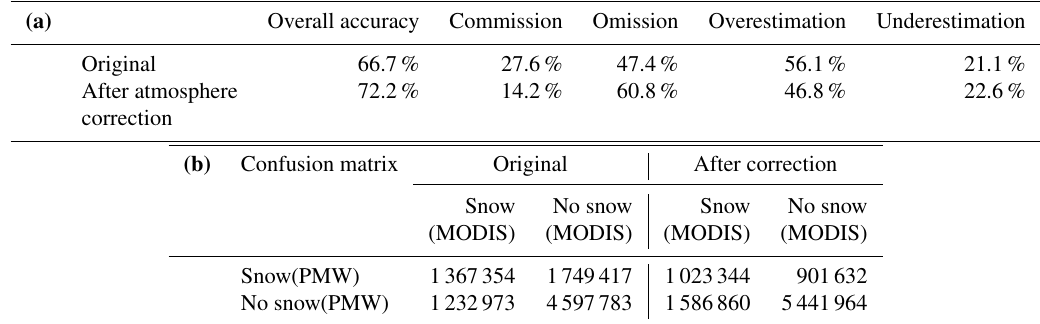
Table 2. Errors in snow cover derived from AMSR-E data and atmosphere-corrected AMSR-E data over the QTP, based on MODIS snow cover fraction (a) , and corresponding confusion matrix (b)